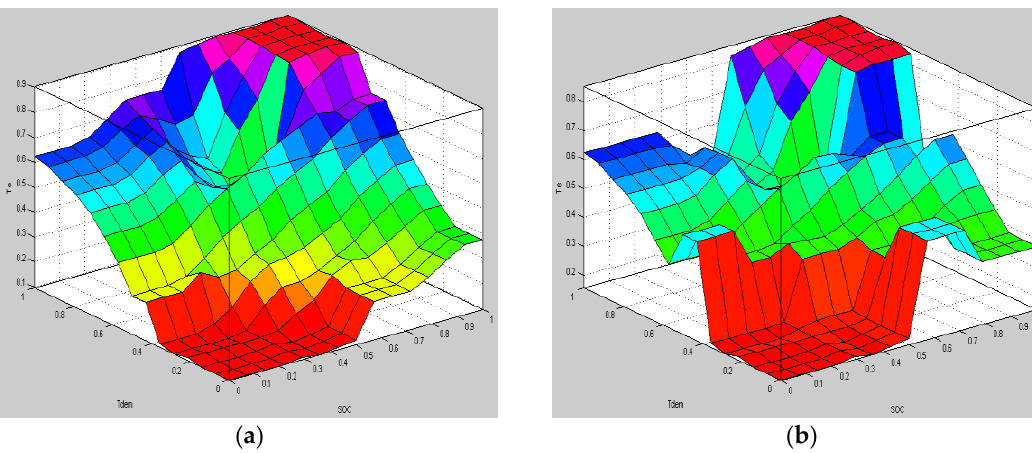
Figure 13. Optimized fuzzy input–output map for driving condition blocks: ( a ) Block ② ; ( b ) Block ④ .